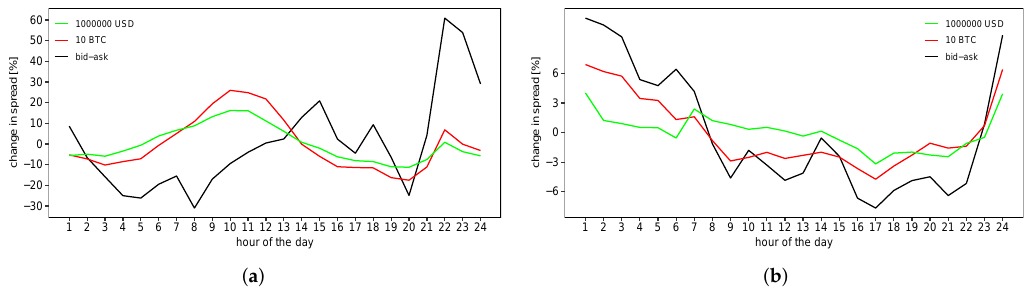
Figure A3. Intraday dynamics of liquidity costs. We display the relative deviation of the average hourly distribution of the bid-ask spread ˜ s ( t ) and liquidity costs ˜ vs ( ω , t ) for 10BTC and 10 6 USD from the mean value. ( a ) Coinbase BTC/USD market. The hour of the day is given in San Francisco time; ( b ) Bitstamp BTC/USD market. The hour of the day is given in Berlin time.